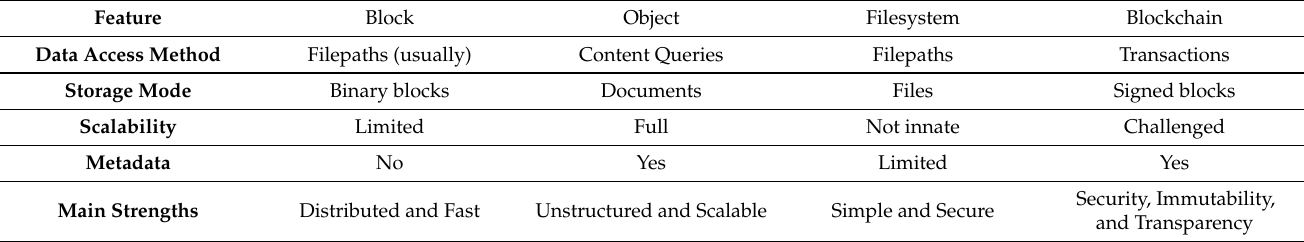
Table 1. A taxonomy of the different storage